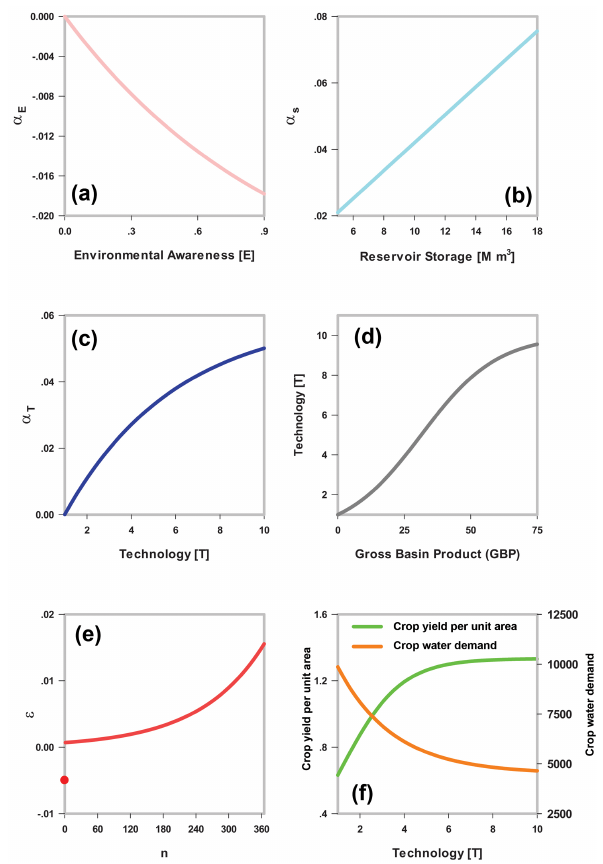
Figure 7. Calibrated constitutive relationships: (a) environmental awareness E vs. 1315 population growth rate α E ; (b) reservoir stor- age S vs. population growth rate α S ; (c) technology T vs. popula- tion growth rate α T ; (d) gross basin product vs. technology T ; (e) water shortage days n vs. rate of change of environmental awareness ε (red dot represents the forgetting rate); (f) technology T vs. crop water demand γ s and crop yield γ r (see Table 2 for more details).